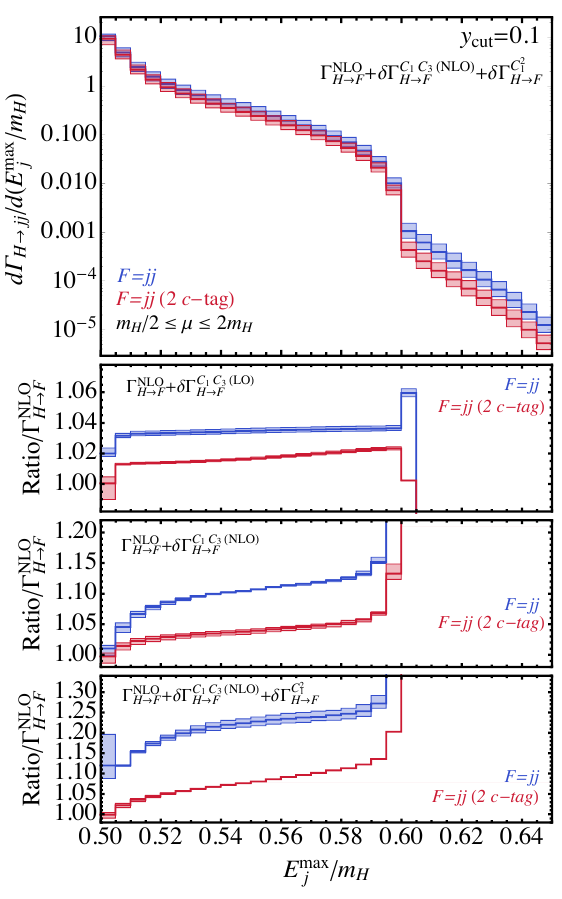
Figure 8. Differential predictions for the ( m H -scaled) energy of the leading jet in 2-jet events (in H → cc decays) defined with y cut = 0 . 1 . Results are presented for a variety of different requirements on the final-state jets, either requiring exactly two jets H → jj (blue) or exactly two c -tagged jets (red). The lower panels present the impact of the mixed EFT- y c piece at O ( α 2 the combined EFT- y c and EFT 2 pieces at O ( α 3